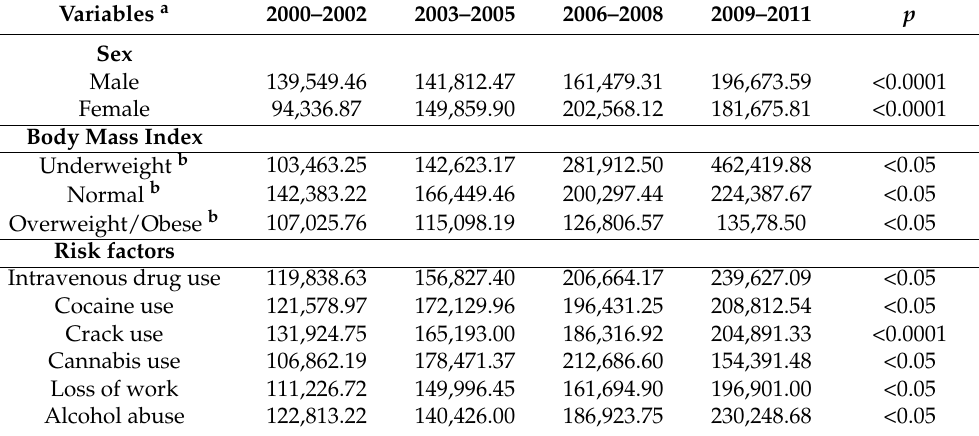
Table 3. Estimated marginal means across time (linear trend design) in subjects with detectable viral